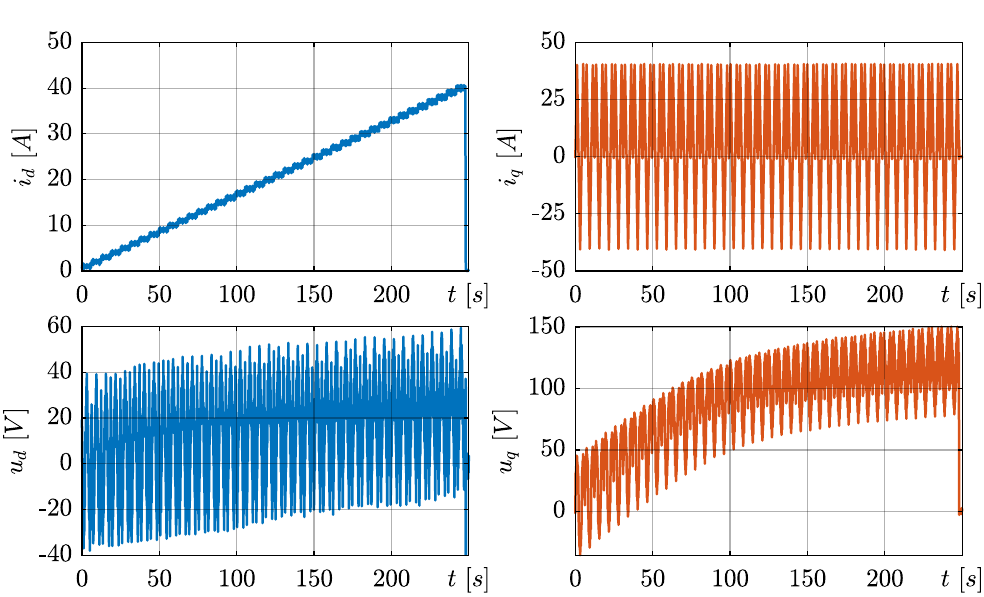
Figure 12. Current and reference voltage waveforms during the complete identification